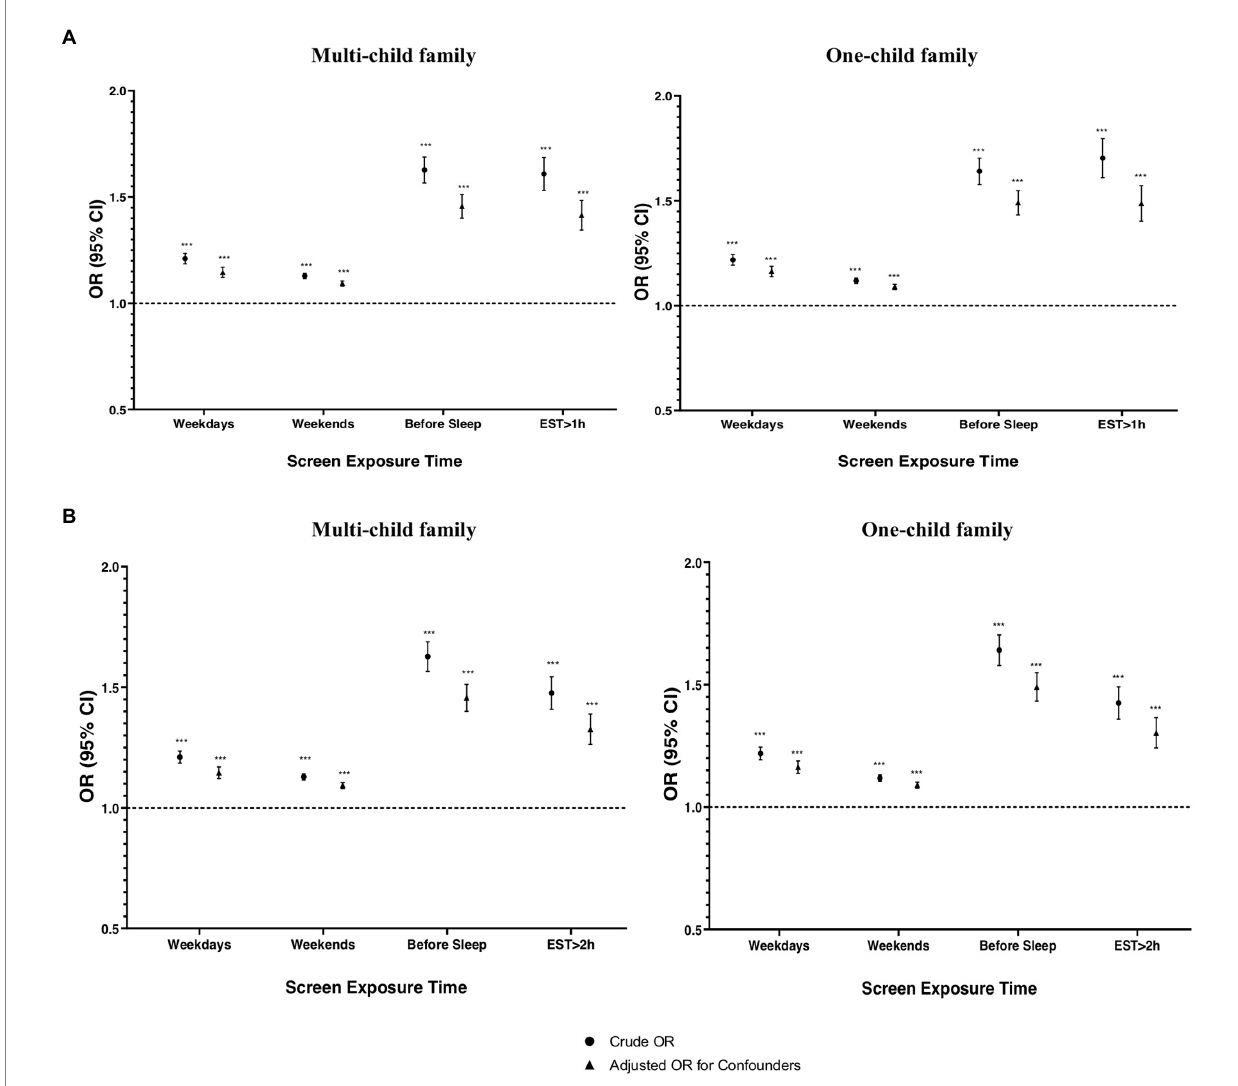
FIGURE 3 The association between screen time and suspected DCD in multi child and one-child family when adjusting or not adjusting for child and family characteristics and maternal health during pregnancy ( n = 129,278). (A) Excessive screen exposure is defined as more than 1 h per day. (B) Excessive screen exposure is defined as more than 2 h per